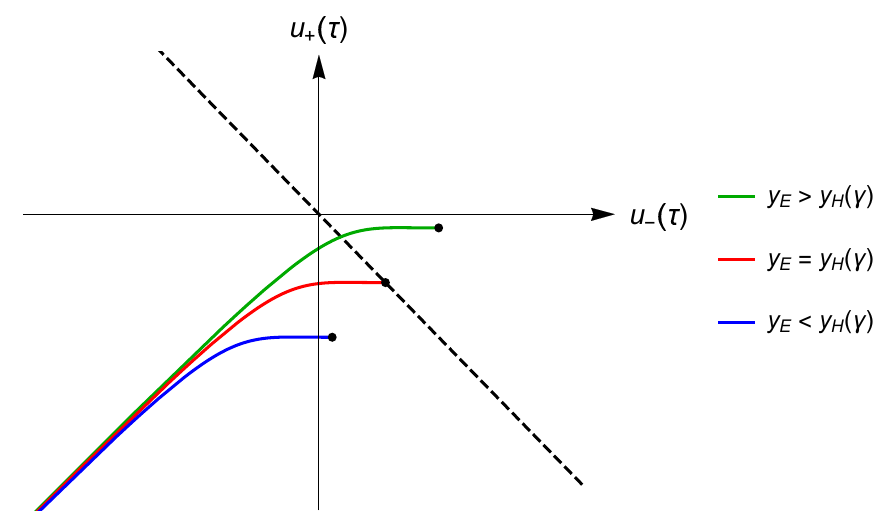
Fig. 5 The transition map U for different values of the parameter y E and γ ∈ ( − 1 , 0 ) . The black points in this figure , u ∗ ) for each represent the point u ∗ = ( u ∗ − +